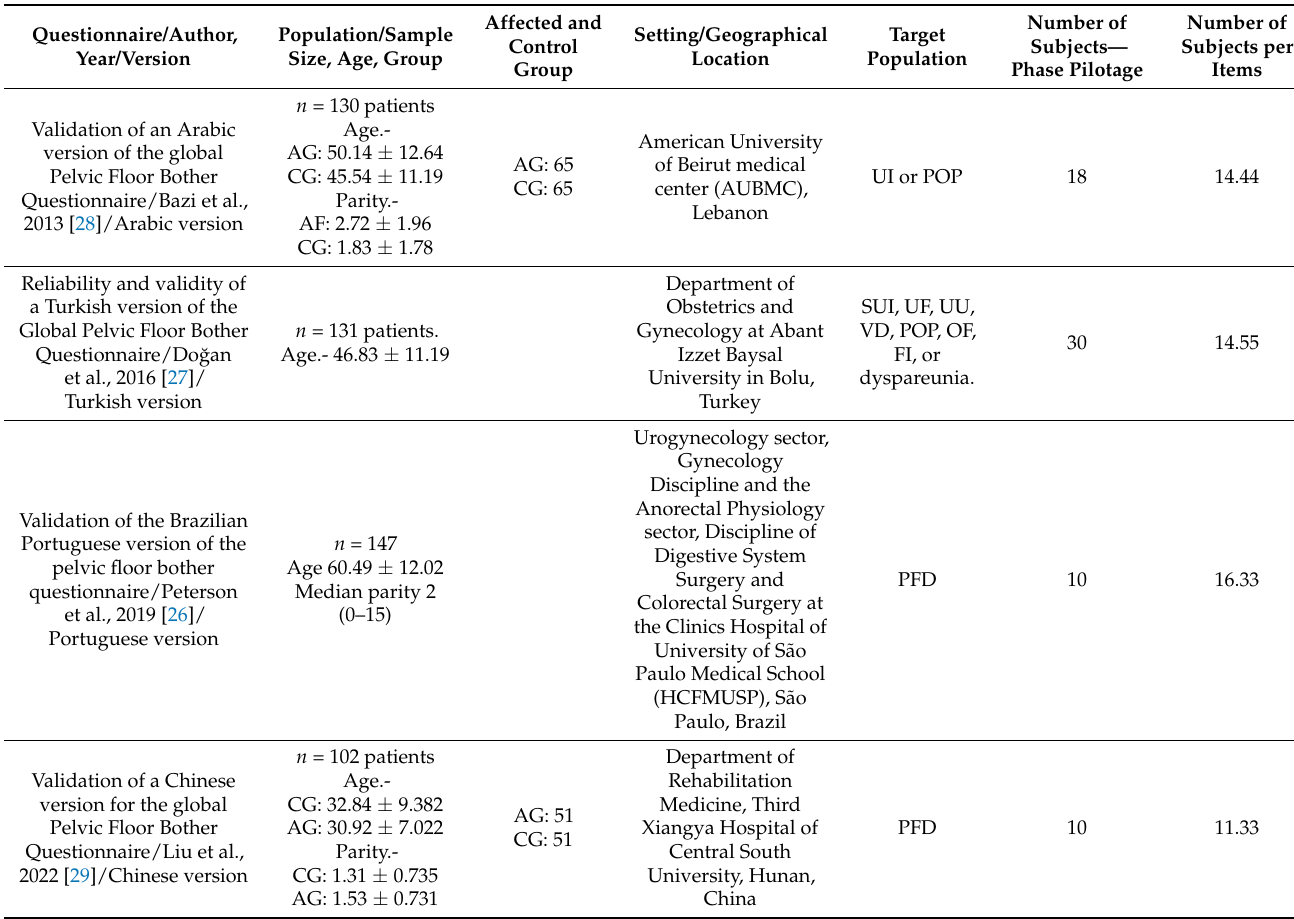
Table 1. Structural characteristics of the